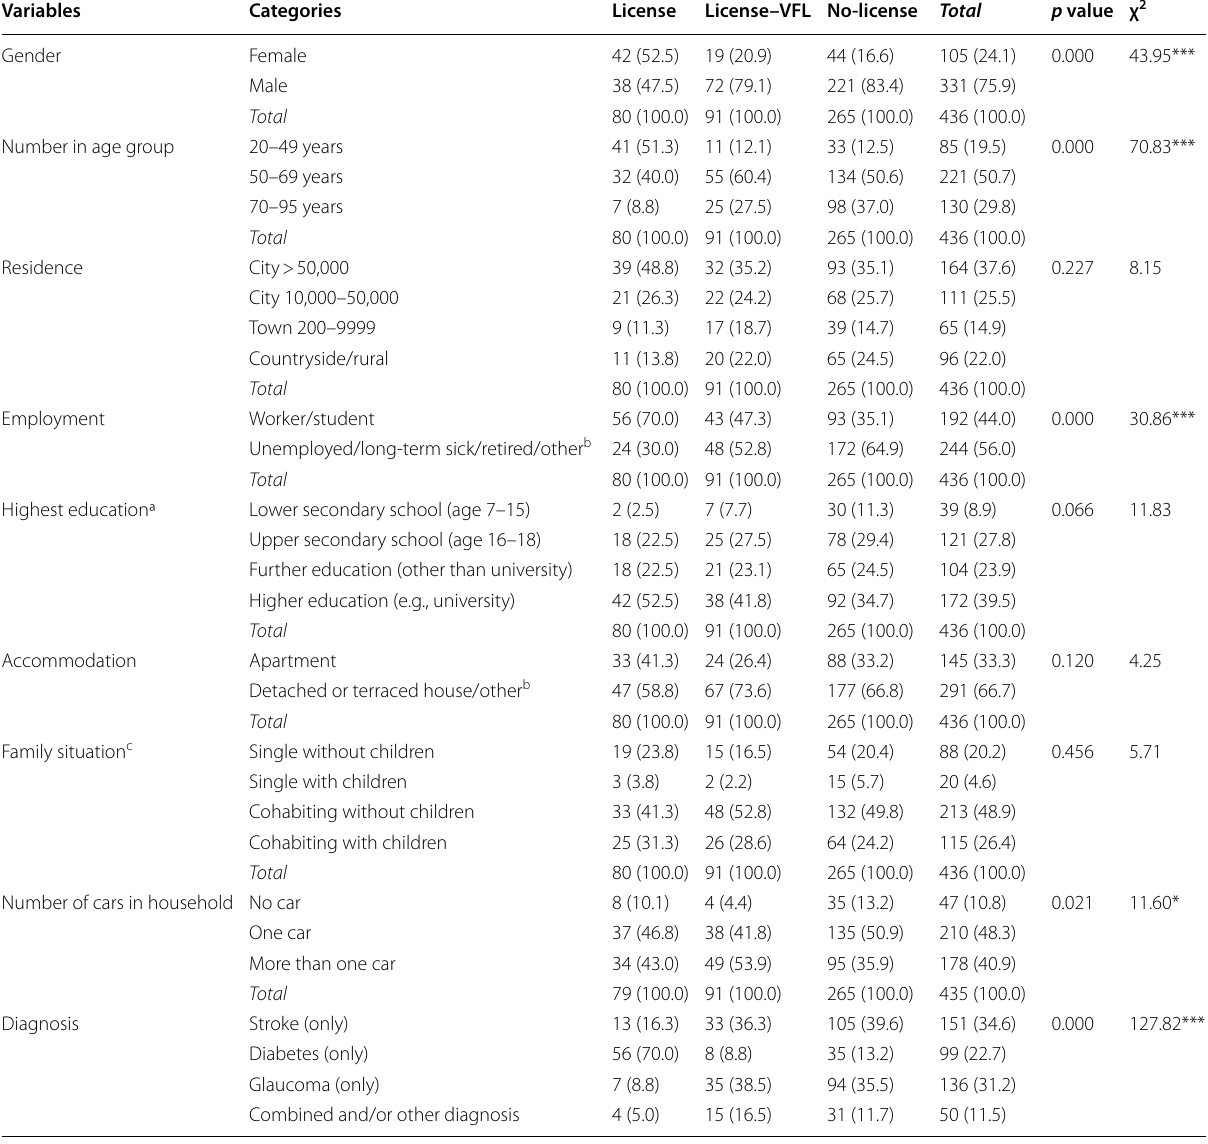
Table 1 Characteristics of the three respondent groups; percentages within